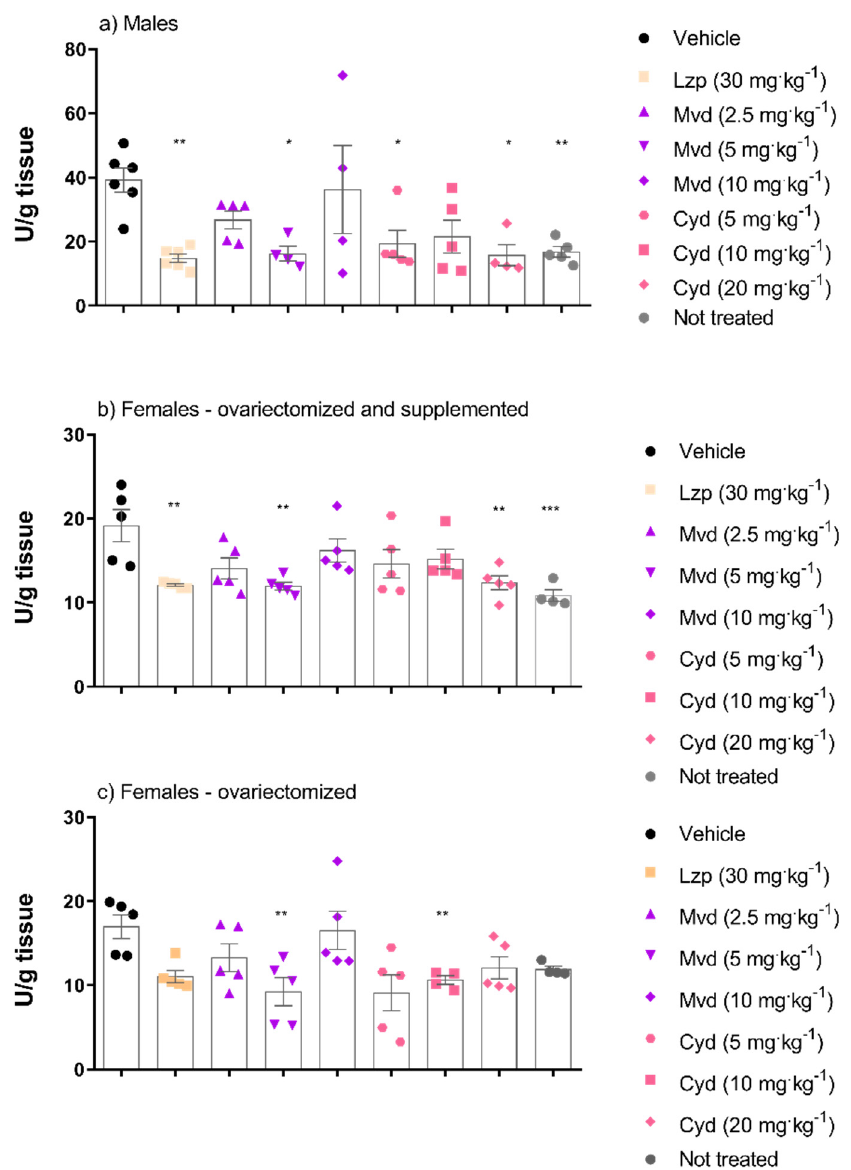
Figure 5. Effects of the malvidin and cyanidin chloride treatment on the MPO activity in the gastric lesions induced by ethanol in the different groups: ( a ) male animals, ( b ) female animals ovariectomized and supplement with 17 β -estradiol (500 µ g/kg) and ( c ) group of ovariectomized female animals without supplementation. Data are presented as mean ± S.E.M. ANOVA followed by the Dunnett’s test; where * p < 0.05, ** p < 0.01 and *** p < 0.001, compared to the respective vehicle group.